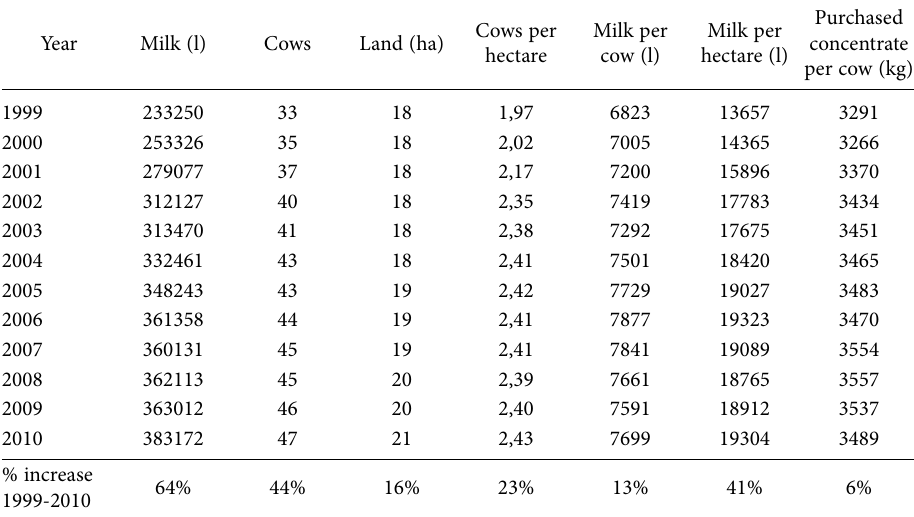
Table 1. Evolution of intensification features (sample